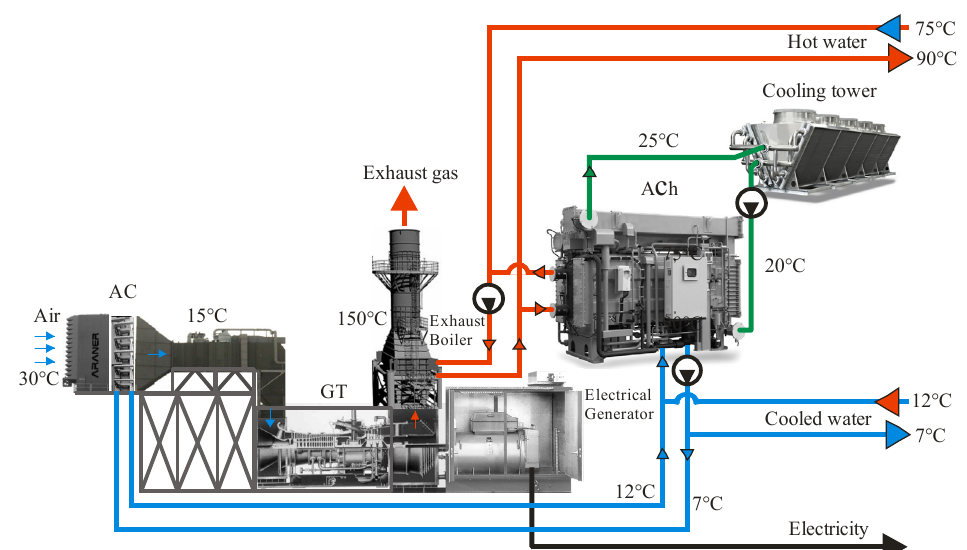
Figure 3. A scheme of gas turbine intake air cooling system with absorption lithium-bromide chiller (ACh) using the heat of exhaust gas: AC—air cooler.